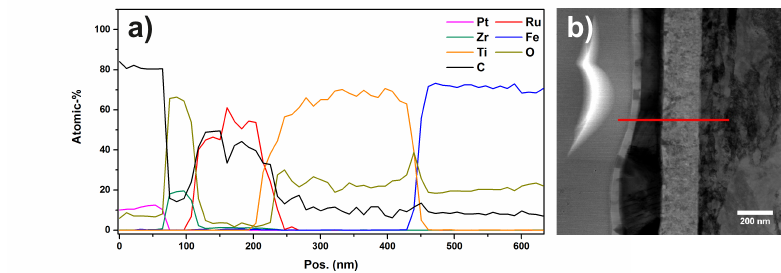
Figure 17. ( a ) EDX linescan of sample “Ru/Ti-1” showing the signal intensities of different elemental peaks. The layer structure is evident by inspecting the intensity ratios; ( b ) STEM DF image, the marker indicates the region in which the linescan was